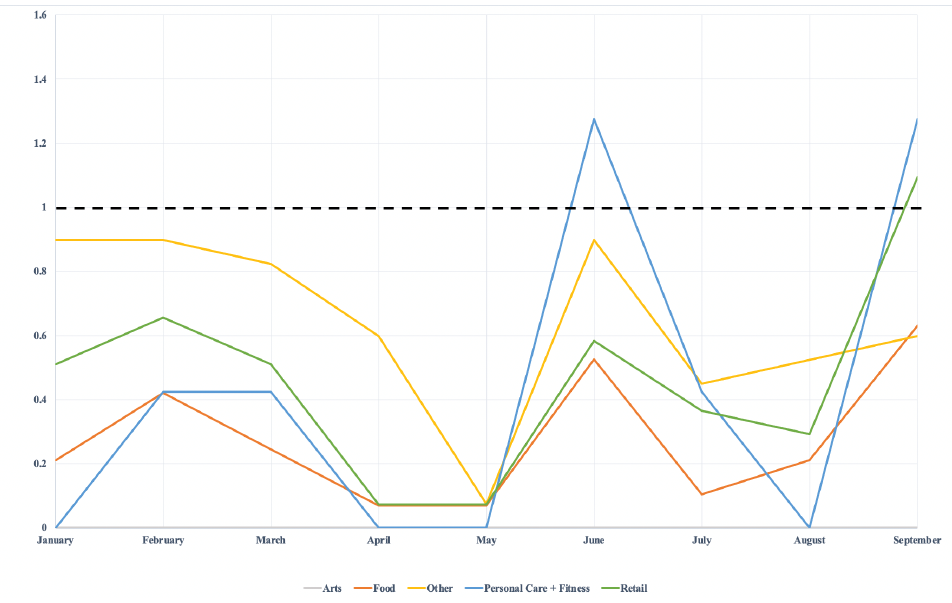
Figure 6: Percent difference in new starts between each month in 2020 and the average number of monthly new starts from January 2016 - December 2019 for chain establishments